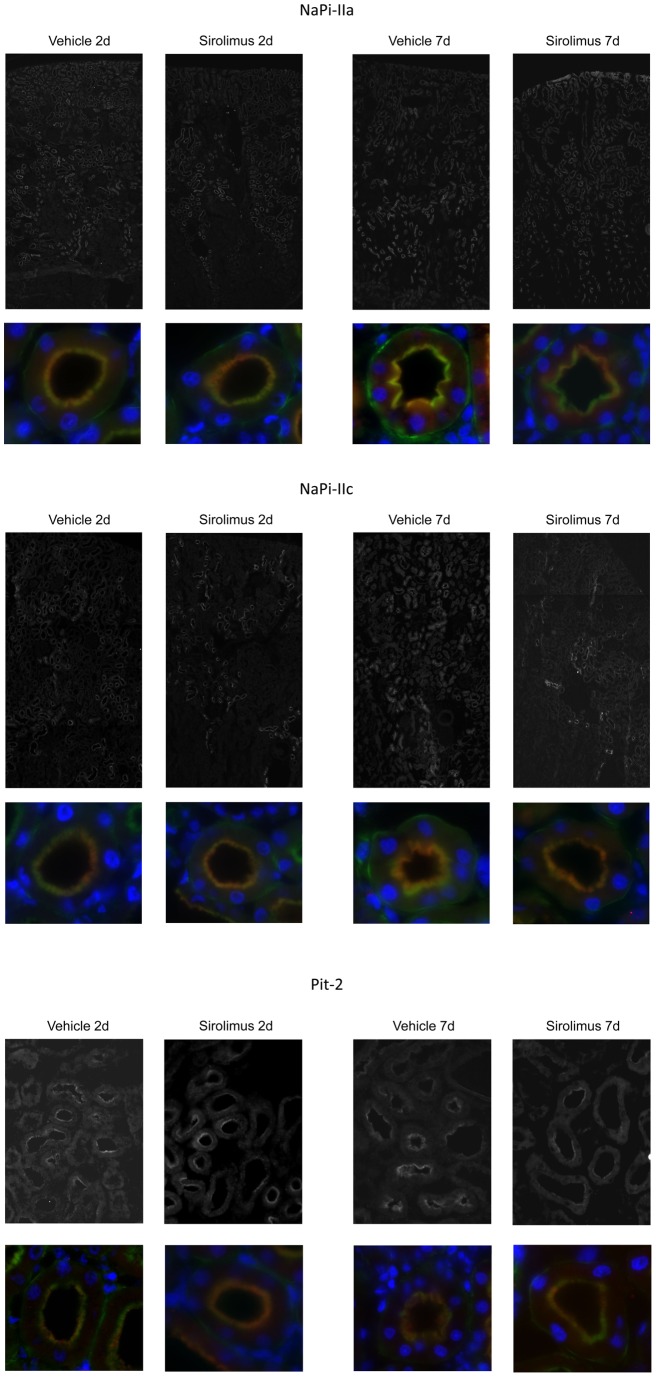
Sirolimus has no effect on localization of renal phosphate transporters.Effect of sirolimus treatment for two and seven days on NaPi-IIa, NaPi-IIc and Pit-2 localization. NaPi-IIa, NaPi-IIc or Pit2 staining (red) was observed in the BBM of early proximal tubules, and colocalized with β-actin as a marker of the BBM (green) as indicated by the yellow overlay. Nuclei were stained with DAPI (blue). No difference was observed between animals treated with vehicle or sirolimus for either 2 or 7 days (n = 5 per group). Original magnification 630 x.